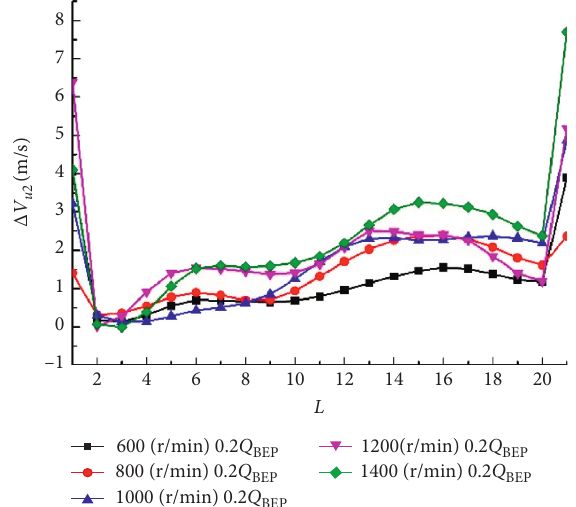
Figure 10: Slip velocity at different speeds.